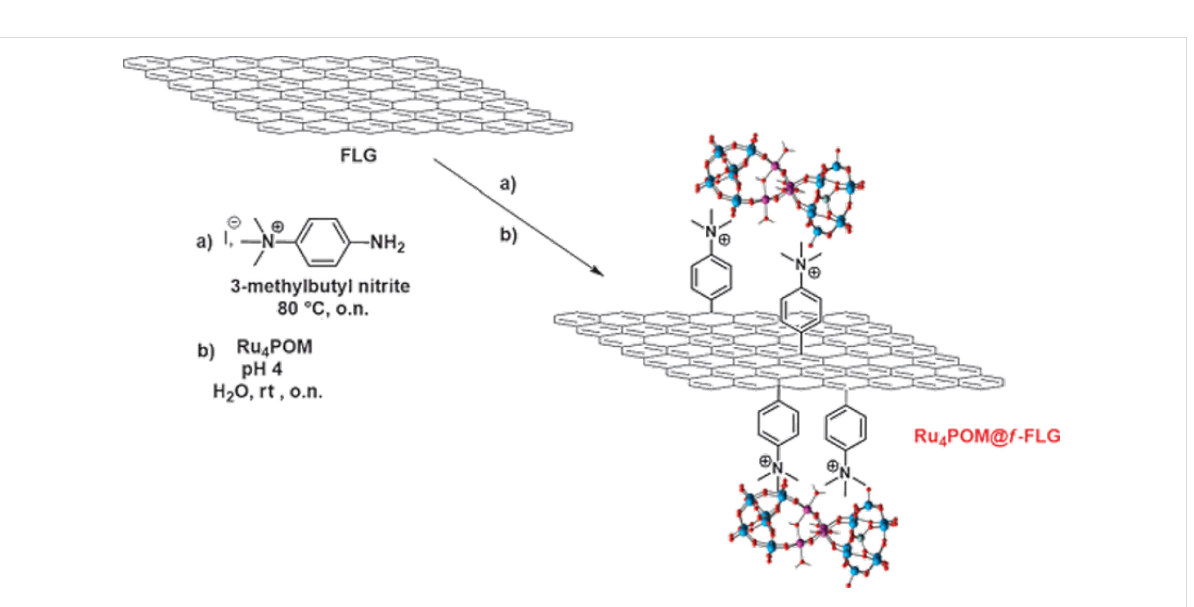
Figure 9: Synthesis of a polyoxometalate–graphene nanohybrid by using the diazonium-based reaction. Reproduced with permission from [45], copy- right 2014 The Royal Society of